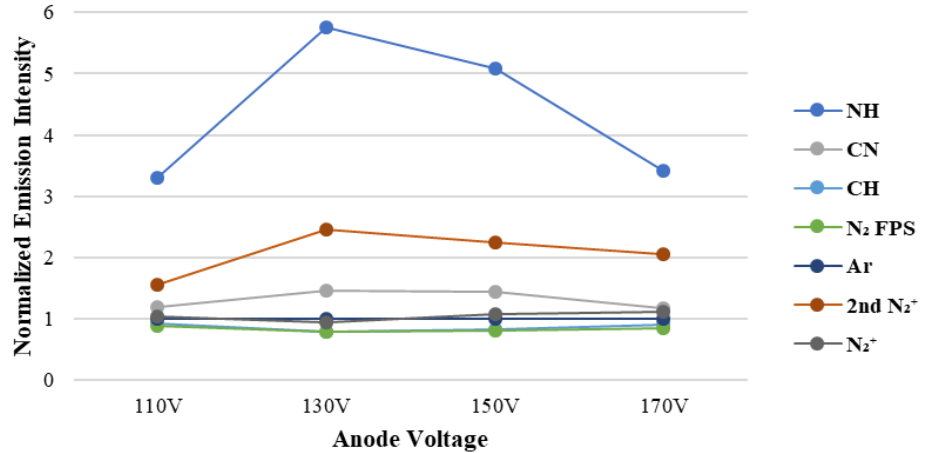
Figure 4. Radical contents of Ar/APTES plasma at different ion source voltages. (The emission intensity of each radical is normalized by the intensity of Ar plasma.) Table 2. Element composition ratio of plasma polymer film on PC substrate.